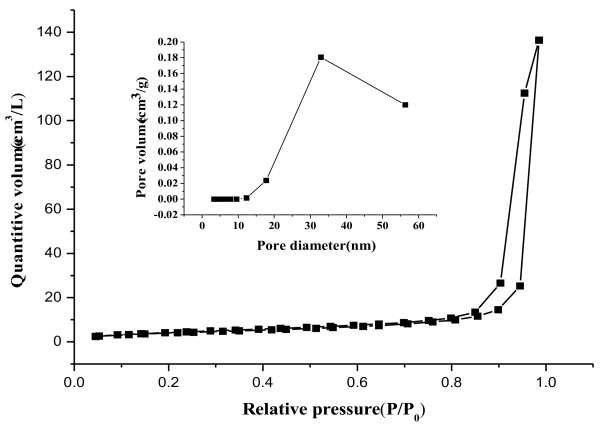
N2adsorption-desorption isotherms of dumbbell-like SrCO3in pure methanol at 50°C. The inset is the corresponding pore size distributions.